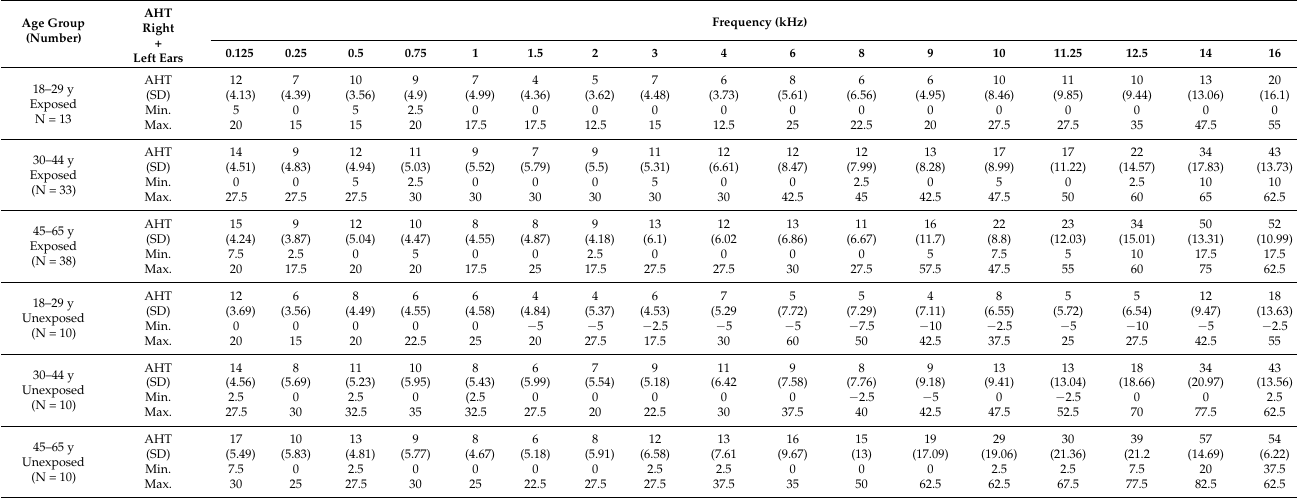
Table 1. Average values, standard deviations, and minimum and maximum hearing thresholds of women exposed and unexposed to workplace